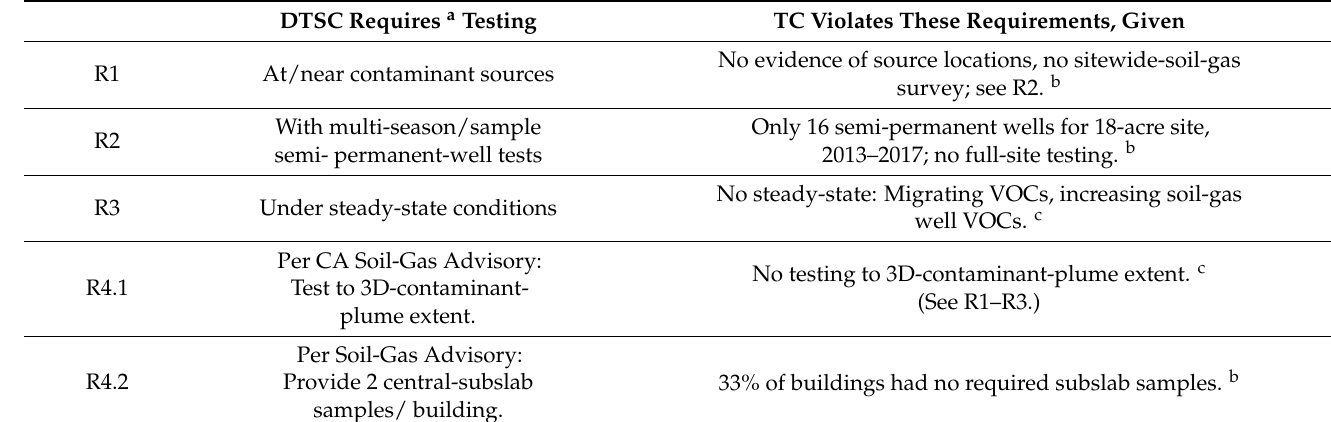
Table 6. Violations of testing requirements , former Santa Fe Railyards, Boyle Heights,